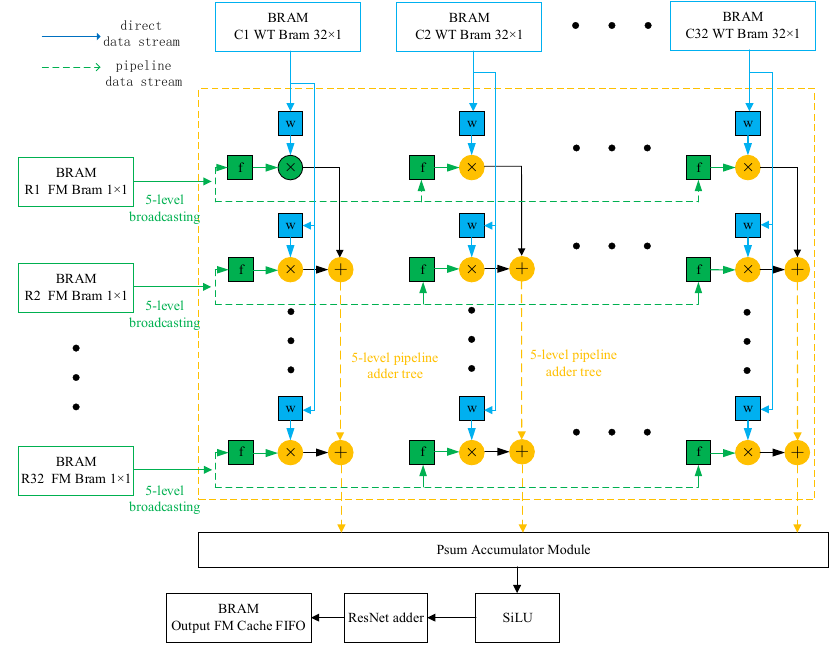
Figure 3. YOLOX-s convolution calculation array architecture.